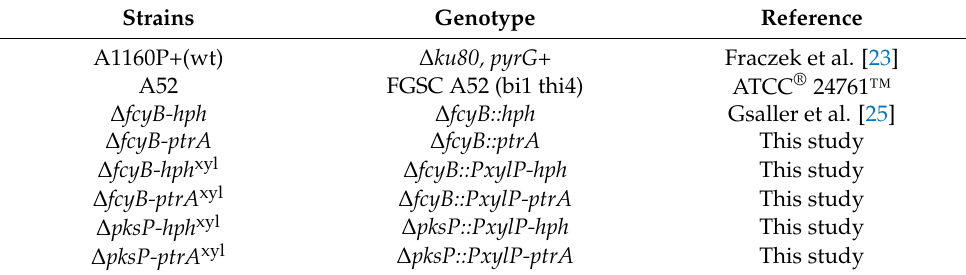
Table 1. Fungal strains used in this